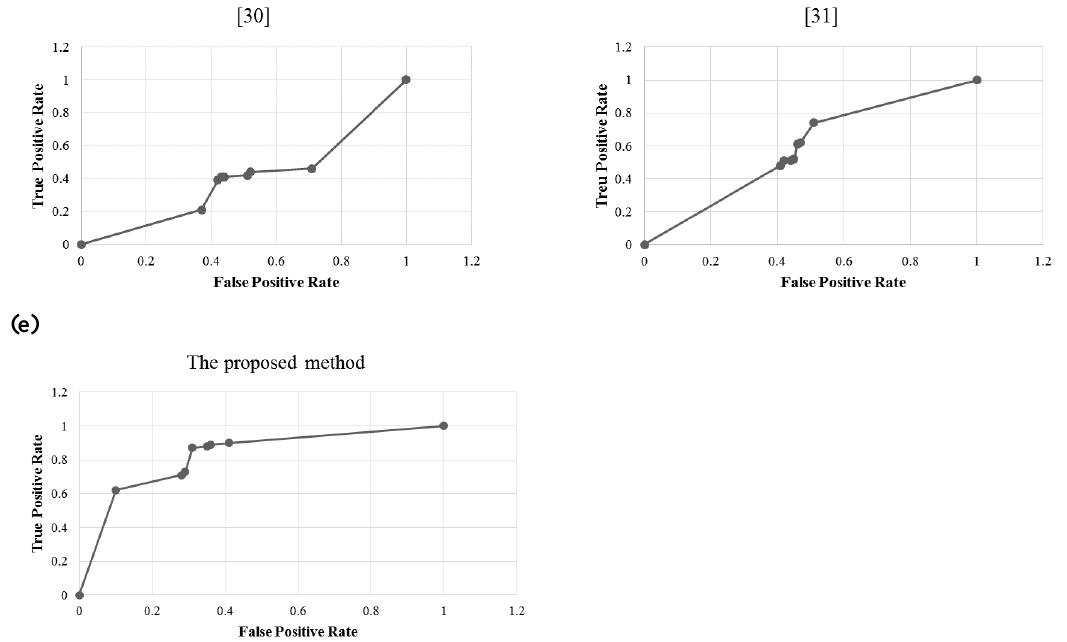
Figure 1. Comparison of ROC curve. (a) ROC curve of [3], (b) ROC curve of [42], (c) ROC curve of [30], (d) ROC curve of [31], (e) ROC curve of the proposed method. Table 5. The AUC value. [3]